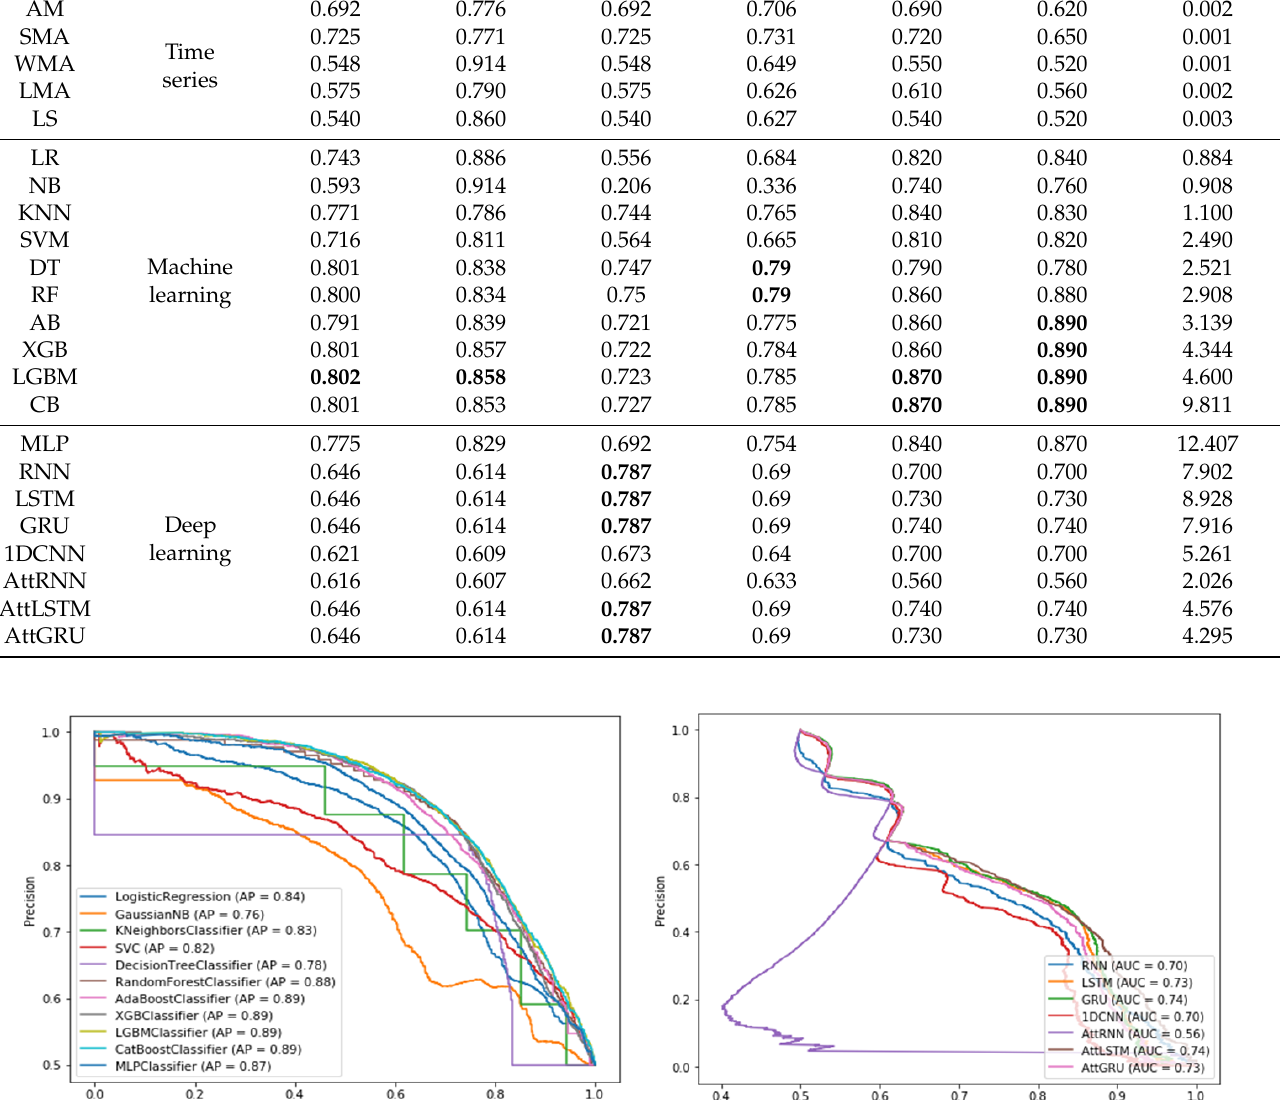
Figure 4. Comparison of the area under the precision–recall curve (AUPR) for the base model.